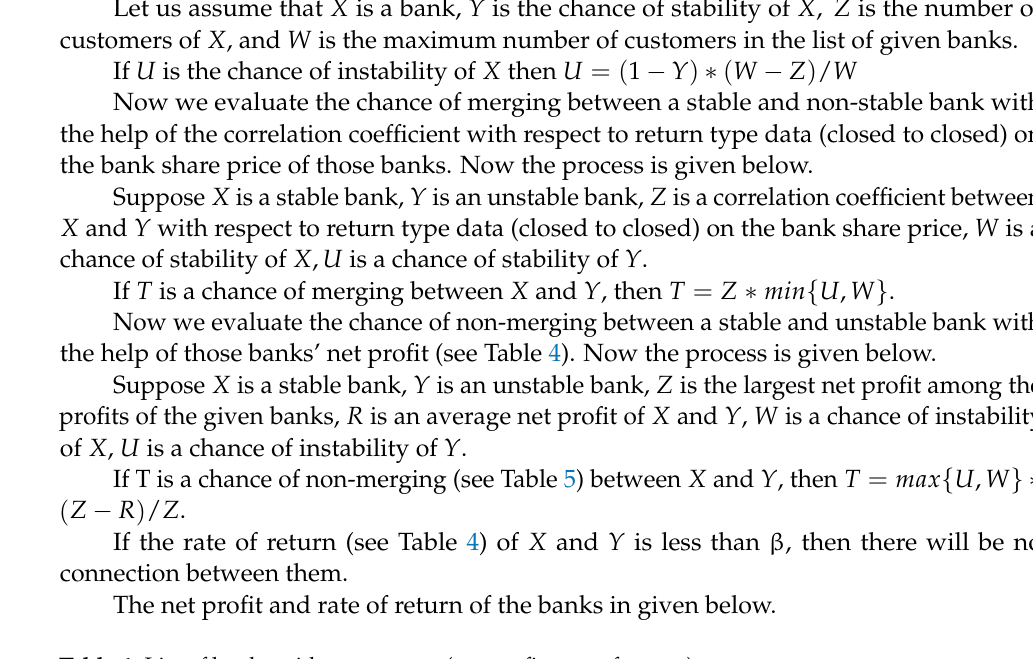
Table 4. List of banks with parameters (net profit, rate of